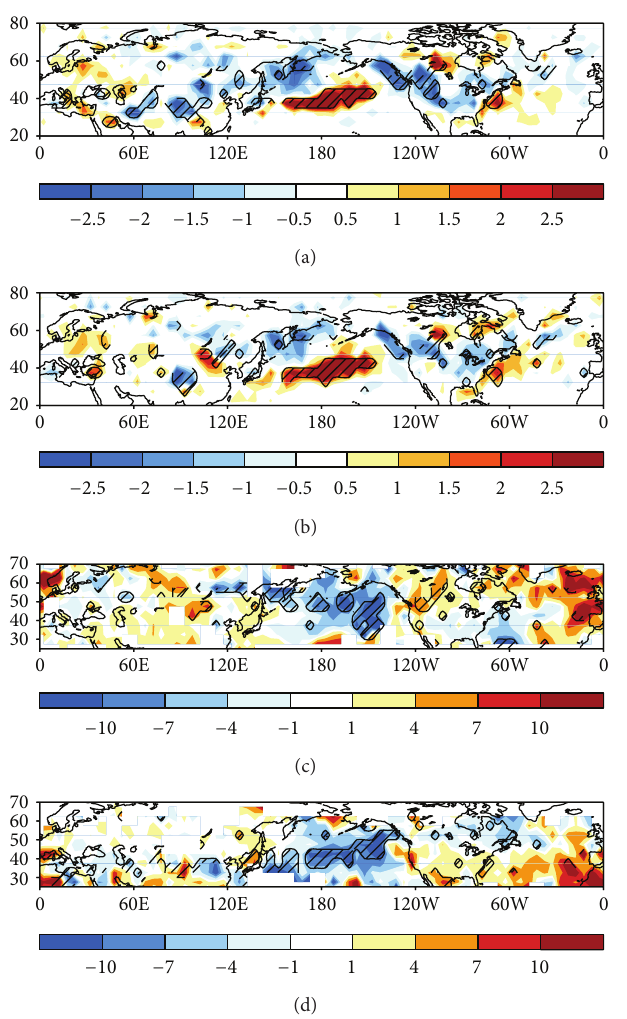
Figure 3: NH winter (JFM) PNA positive-PNA negative cyclone track frequency composite for (a) NCEP1 5801, (b) like (a) but for ERA40 5801. Units: no. of cyclones per 5 ∘ Lat × 5 ∘ Lon box. Hatched areas are significant at 90% for 2-tailed 𝑡 -test. (c) NH winter (JFM) NAO positive-NAO negative cyclone track intensity composite for NCEP1 5801. (d) like (c) but for ERA40 5801. Units: hPa. Hatched areas are significant at 90% for 2-tailed 𝑡 -test.